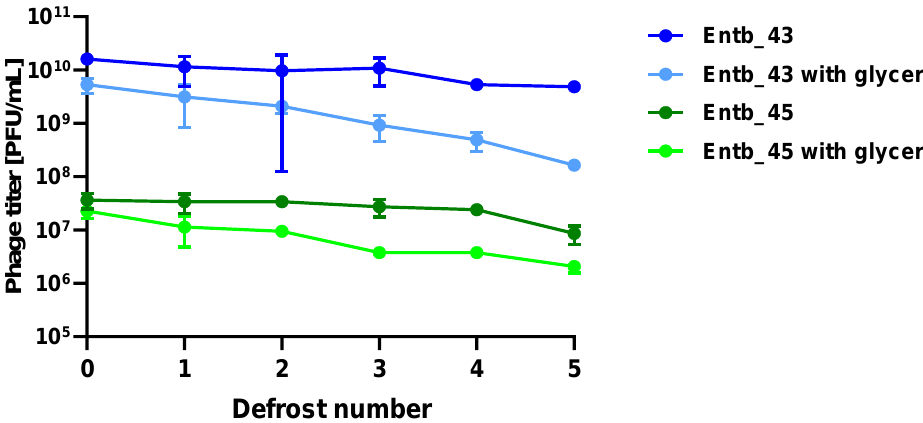
Figure 11. Influence of repeated defrosting on titers of phage lysates with or without 20% glycerol. Error bars represent the standard deviation (±SD) of the mean phage titers.